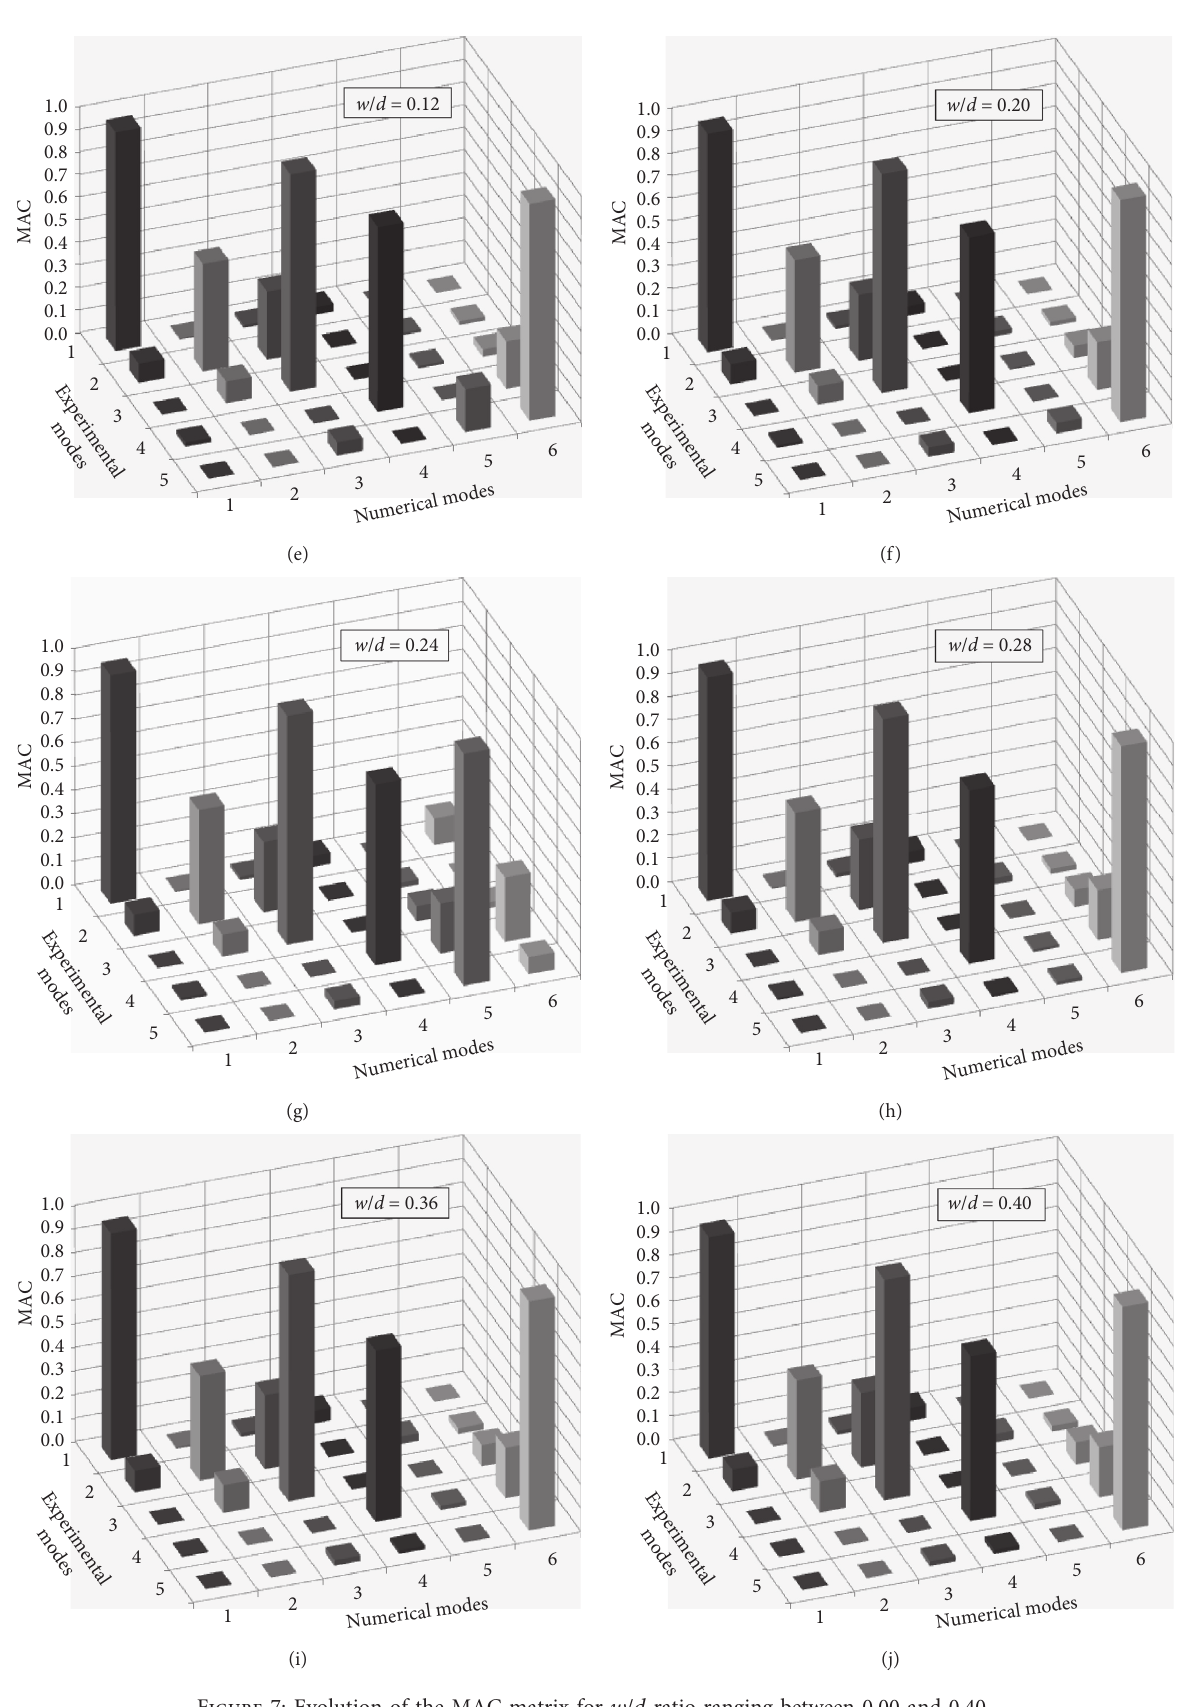
Figure 7: Evolution of the MAC matrix for w / d ratio ranging between 0.00 and